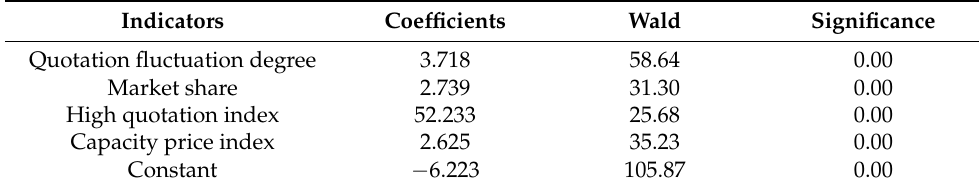
Table 5. SCAD-logit model estimation